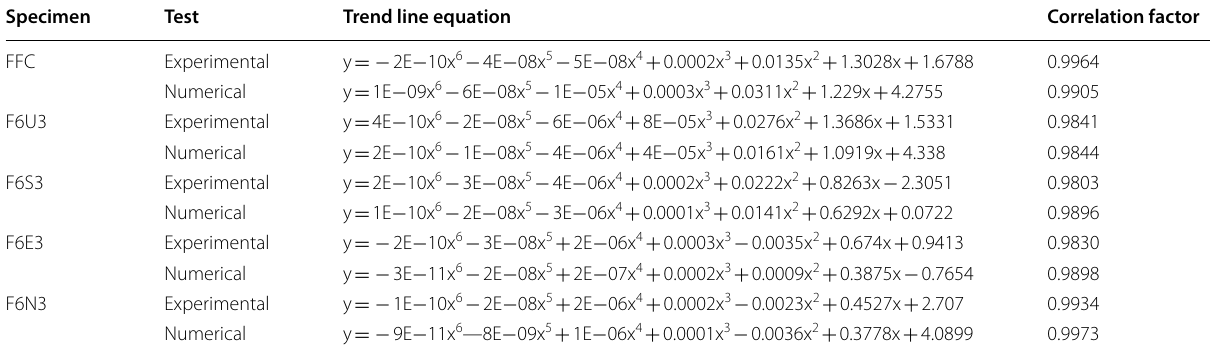
2. The legends of Figure 2 should be updated as below Figure 2c—Casting of HyFRC on the beam–column joint region Figure 2d—Strain gages installed on the steel rein- forcements Figure 2e—Moist-curing of the HyFRC specimens using wet burlap 3. In Table 10 the ‘Trend line equation’ and the ‘Correla- tion factor’ were merged. Below the correct version of the Table